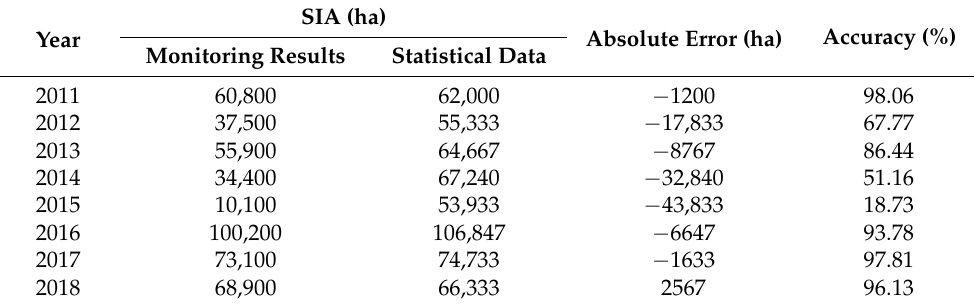
Table 3. Comparison of irrigated area monitoring results and statistical data in 2011–2018.